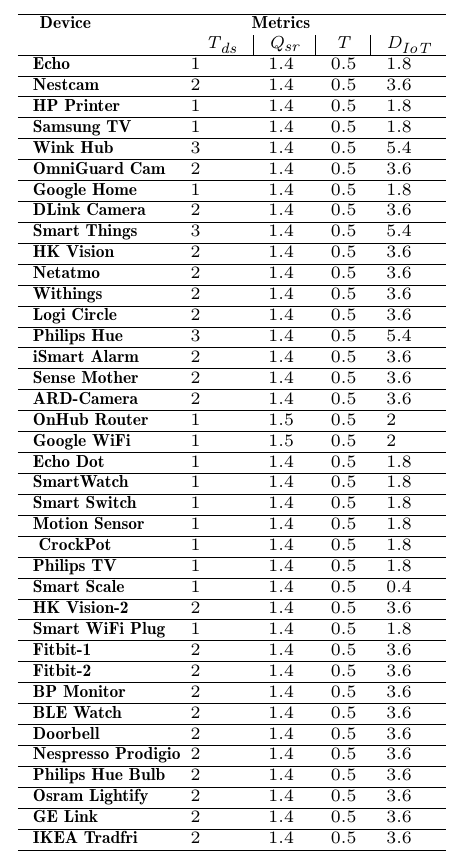
The NPSR was high during an SYN attack while it is the lowest for GREIP and GREETH attacks. This implies that during an SYN attack, the device under attack receives and responds to packets at a higher rate when compared to the other attack types. GREIP attack has the least NPSR value of 0 . 00023. The IP camera had the least resilience to VSE and UDP attacks. The IoT resilience value for VSE is 2 . 6 E − 10 s/p 2 and UDP is 3 . 8 E − 10 s/p 2 . The IP camera shows a higher resilience compared to the other attacks for DNS attack type with a value of 1 . 6 E − 05 s/p 2